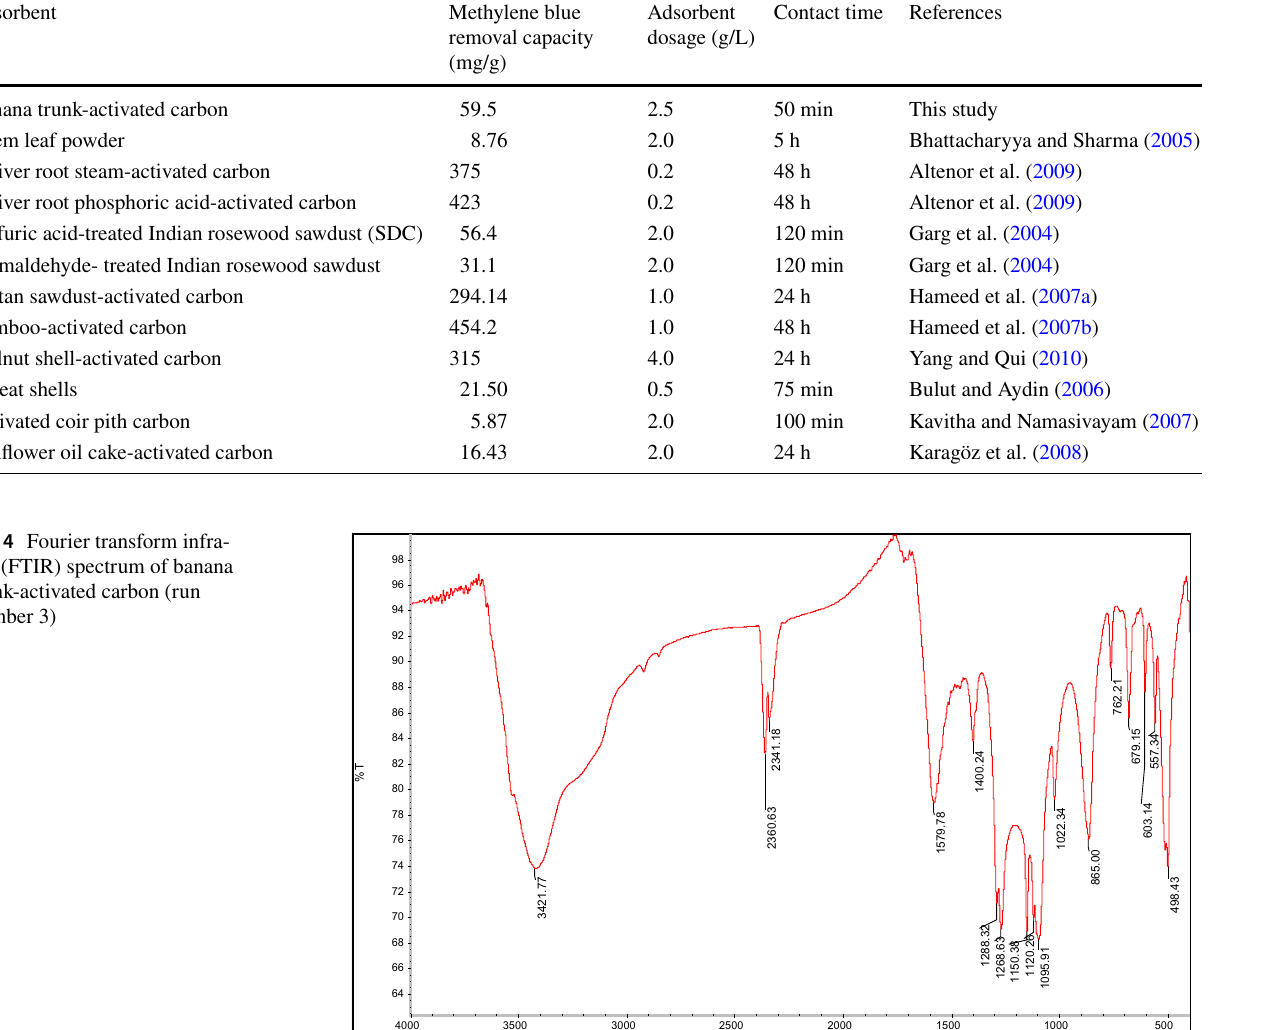
Table 5 Comparison of the methylene blue adsorption capacities by various agricultural waste and by-products Adsorbent